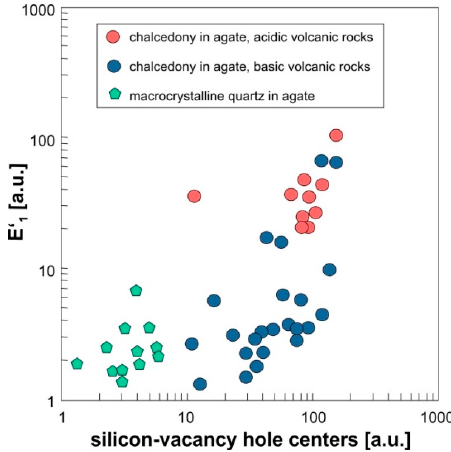
Figure 12. Relative abundances of silicon ‐ vacancy hole centers (O 2 − , O 23 − , O 3 − ) and the Figure12. Relativeabundancesofsilicon-vacancyholecenters(O 2 − , O 23 − , O 3 − )andtheoxygen-vacancy oxygen ‐ vacancy electron center E’ 1 in chalcedony of agates from acidic and basic volcanic rocks, electron center E (cid:48) 1 in chalcedony of agates from acidic and basic volcanic rocks, respectively, as well as respectively, as well as macrocrystalline quartz in agates (data from Götze et al. [107]). macrocrystalline quartz in agates (data from Götze et al.